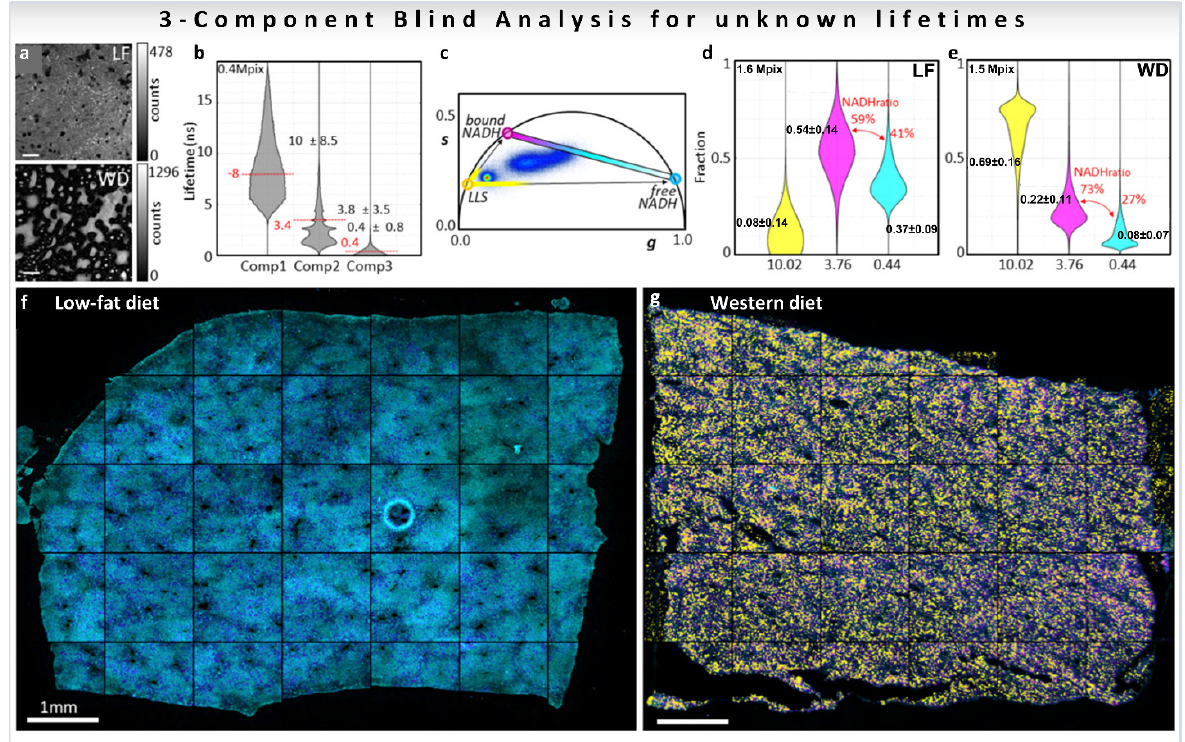
Figure 12. Biological example of three-component blind analysis (unknown lifetimes of the components) using harmonics of phasor. Study of metabolic changes in liver tissue samples using three-component blind recovery analysis. ( a ) Intensity images of livers of mice fed with low-fat diet (LF, top) or Western diet (WD, bottom) ( b ) Recovered lifetimes using three blind components are represented as gray violin plots and the median ± SD. Expected lifetime values for individual species are shown with a horizontal red line. ( c ) Phasor plot for the first harmonic (second and third harmonics phasor plots are not shown). Colored circles on the universal circle indicate the recovered first harmonic phasor position of free NADH (cyan), protein-bound NADH (purple), and LLS (yellow). Fractional intensity distributions of the three components in LF ( d ) and WD ( e ) samples. Color-coded phasor-FLIM liver images of mice fed with LF ( f ) or WD ( g ). The free-to-protein-bound ratio (not including LLS) is color-coded using a magenta to cyan colormap with a yellow overlay for LLS (with values above 75%). (Panels adapted with permission from [38]).